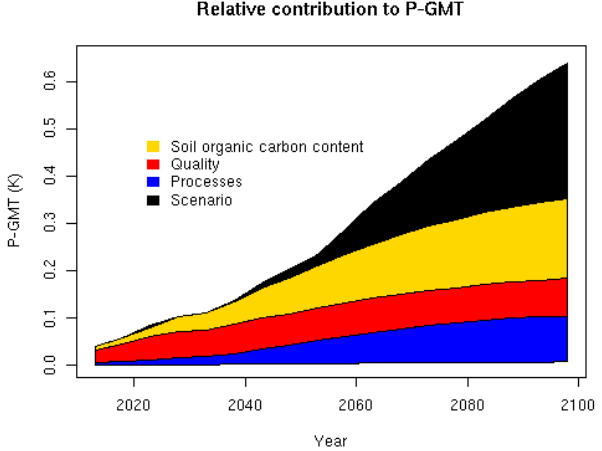
Fig. 10. The relative contribution to the overall spread in P-GMT Figure 10. The relative contribution to the overall spread in P-GMT by the 4 groups of by the 4 groups of uncertainties examined here: scenario, quality of carbon, distribution of carbon and soil decomposition model param- uncertainties examined here: scenario; quality of carbon, distribution of carbon and soil decomposition model parameters.